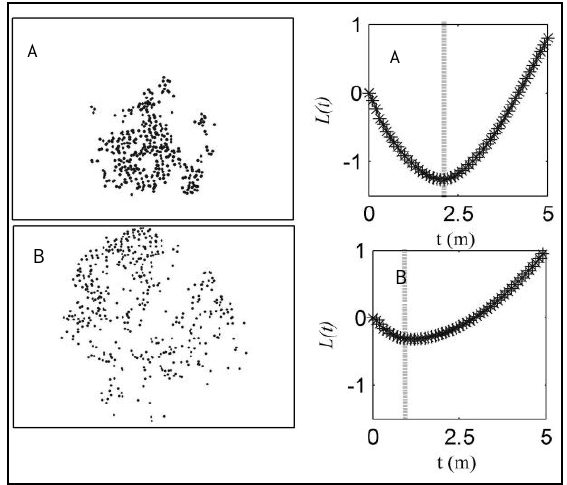
Figure 2. The ˆ L function derived from the LiDAR points of the two layers demonstrated in Figure 1. The dash line indicates the location of the radius scale t ( Tpeak ) where the points tend to be clumped to the maximum